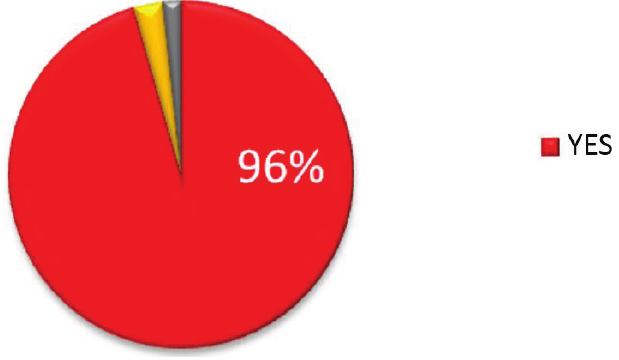
Figure 8. Proportion of patients who would recommend the